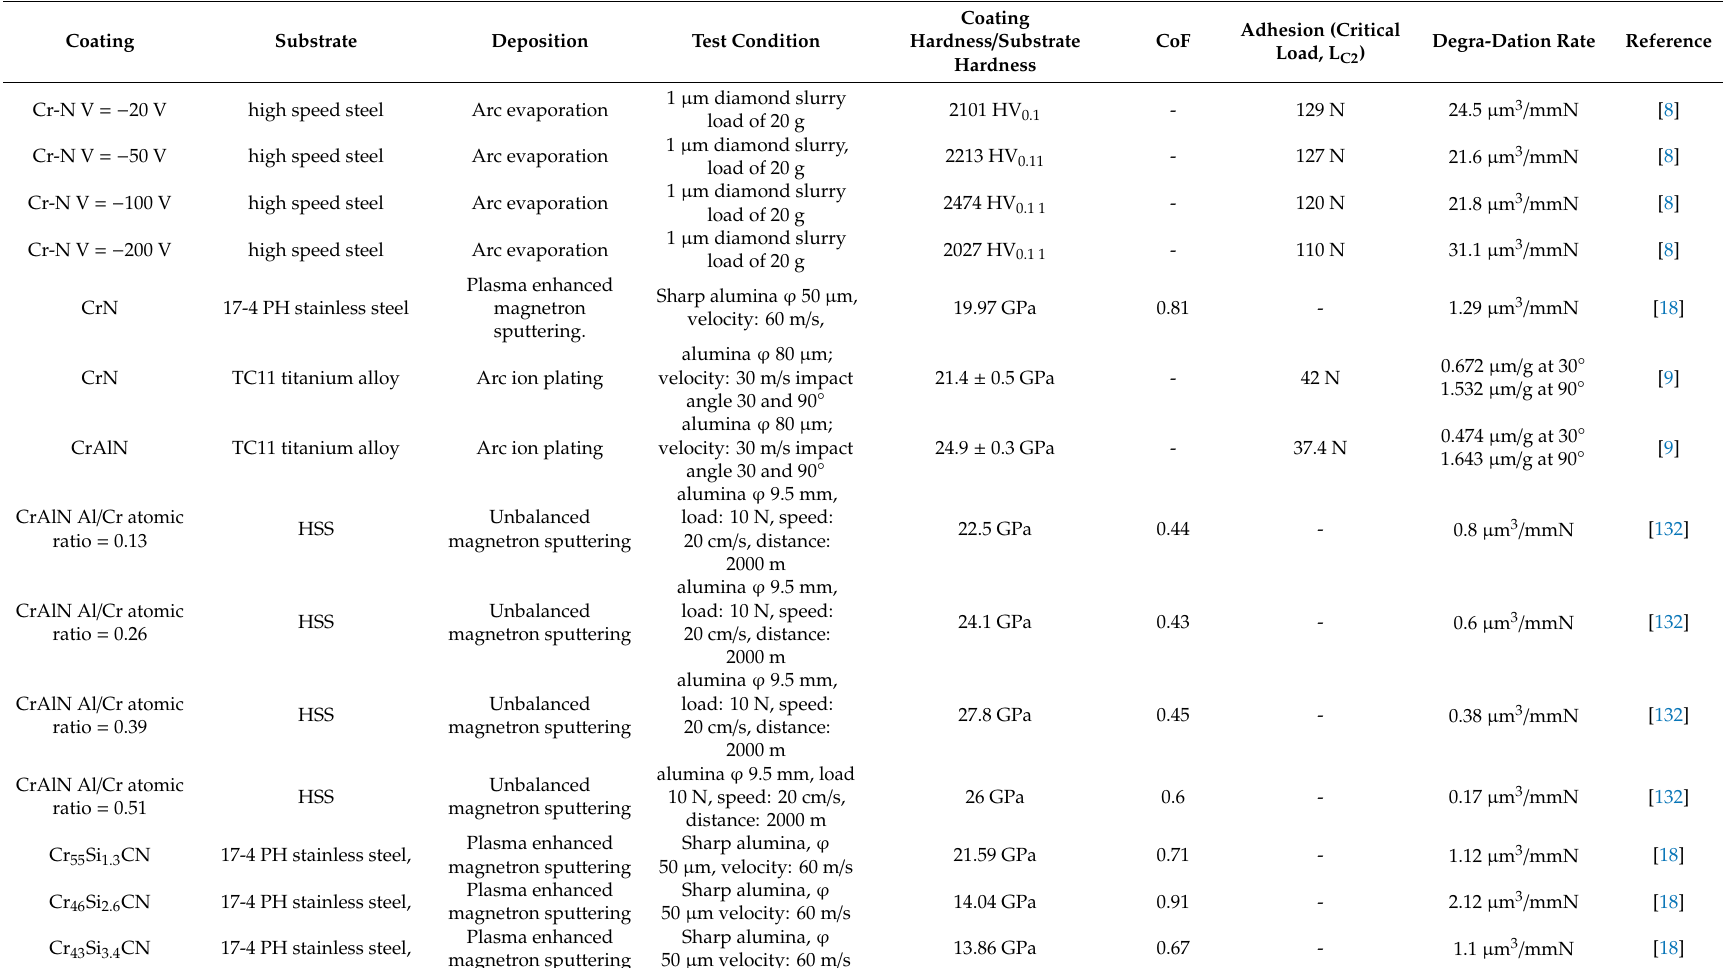
Table 2. Degradation rate of PVD